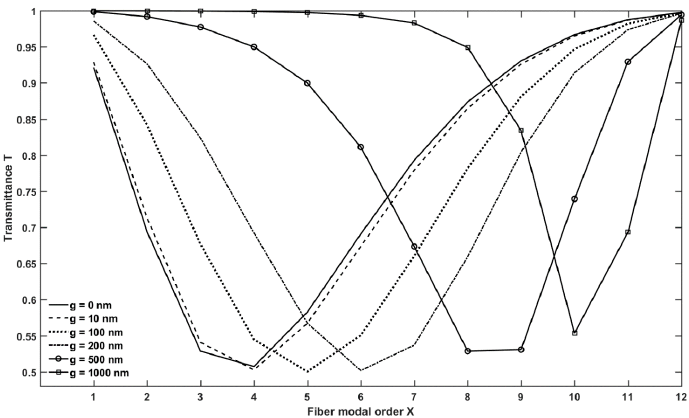
Figure 6. Transmitted power of the microbubble-based setup, calculated for different gap values, ranging from g = 0 nm to g = 1000 nm.